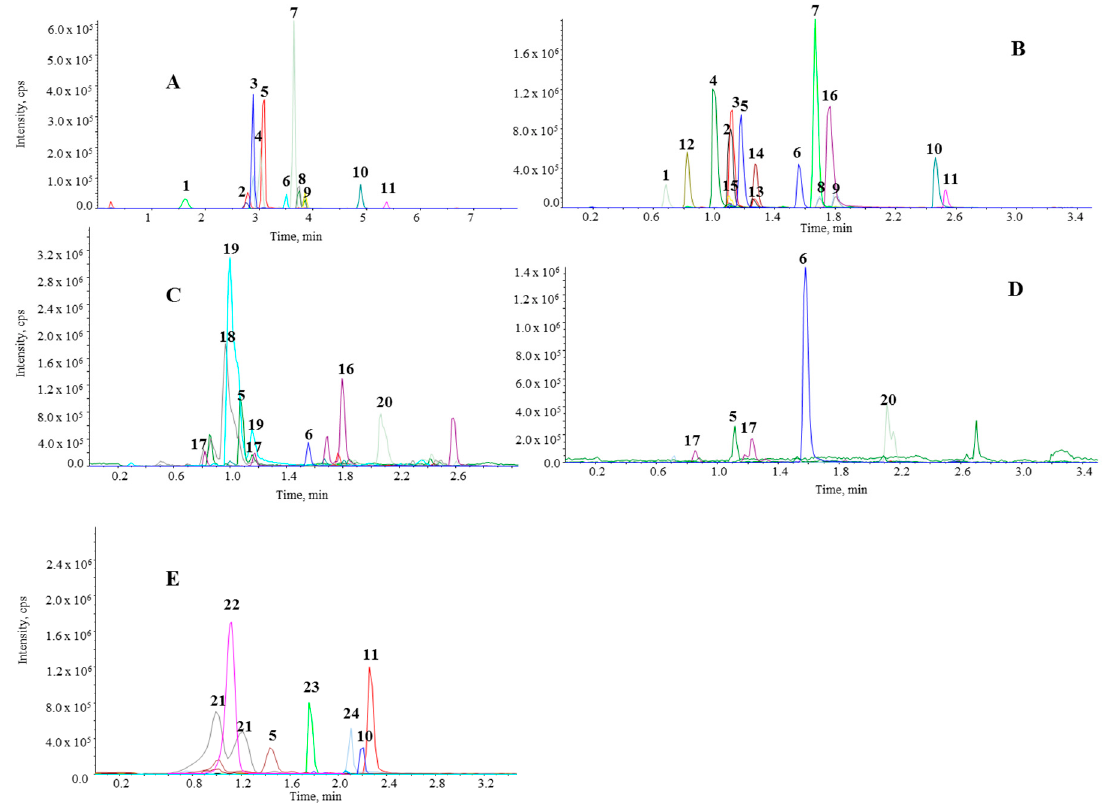
Figure 1. Chromatograms of standards solution obtained by HPLC-MS/MS ( A ) and UHPLC-MS/MS ( B ) analysis. Chromatograms of urine at 6 h ( C ), plasma at 1 h ( D ) and tomato sauce ( E ). Peaks: (1) 4-hydroxyhippuric acid; (2) hippuric acid; (3) dihydrocaffeic acid; (4) 5-caffeoylquinic acid; (5) caffeic acid; (6) ethylgallate (IS); (7) 3-(3-hydroxyphenyl)propionic acid; (8) ferulic acid; (9) isoferulic acid;